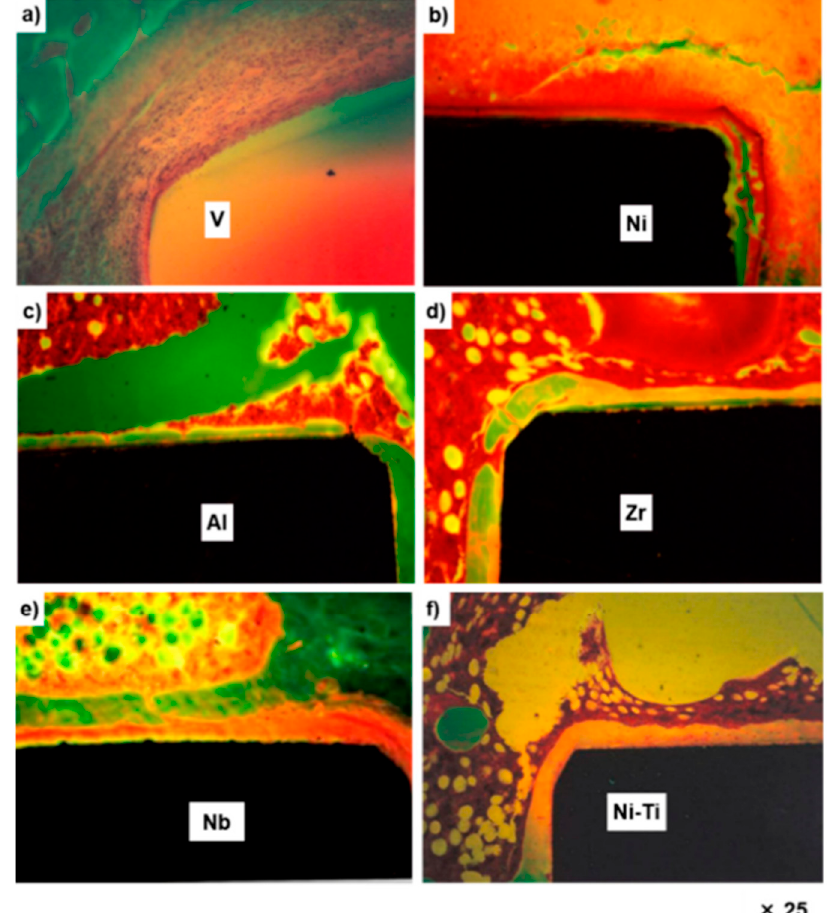
Figure 16. Following 52 weeks, optical microstructures of bone developed surrounding bare V, Ni, Al, Zr, and Nb metals and Ni-Ti alloy ( a – f ). Metal implants are visible as black shadows. The transplanted sample for V was discarded while the section was being prepared. Reprinted with permission from [72]. Copyright 2021 MDPI. Distributed under Creative Commons Attribution-based license (CCBY 4.0.).